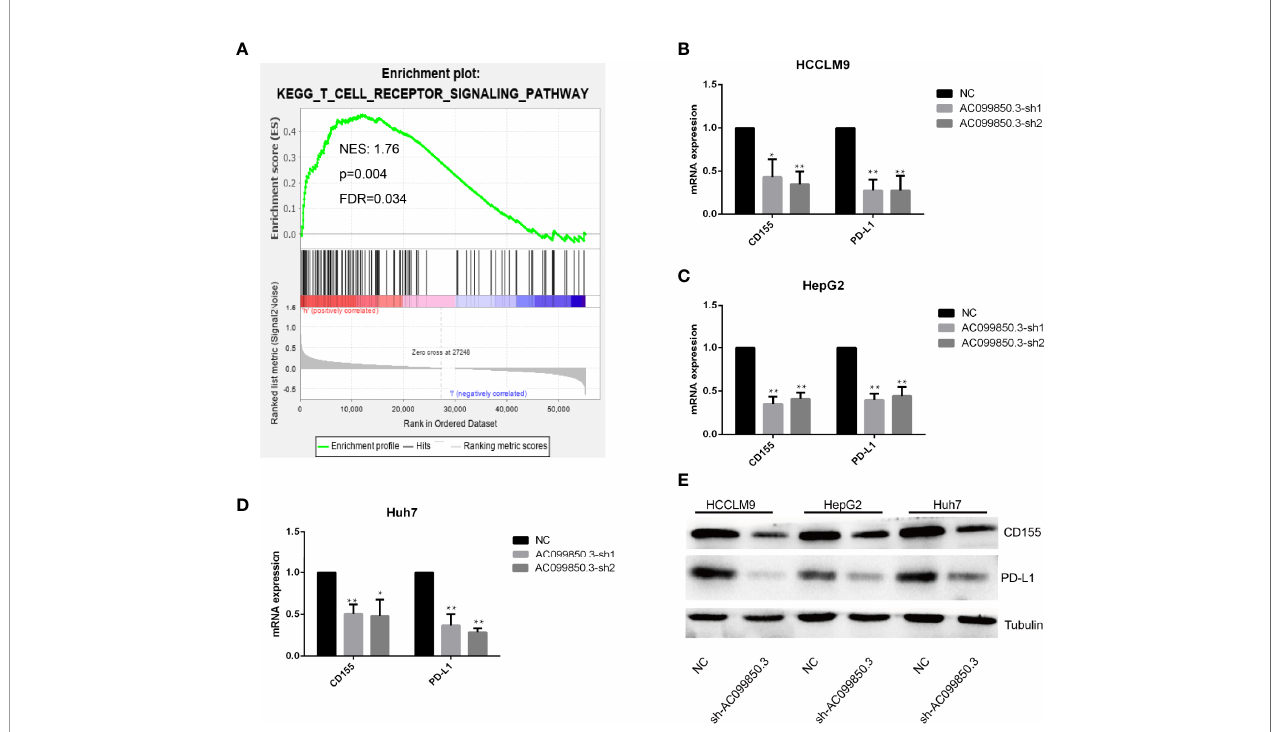
FIGURE 11 | The relevant immune mechanism of AC099850.3. (A) GSEA showed that AC099850.3 was related to the T cell receptor signalling pathway. About the legend as described in the above Figure 10A. (B – D) The results of the PCR assay showed that the interference groups had inhibited expression of the molecules CD155 and PD-L1. (E) The results of the western blotting assay showed that the interference groups had inhibited expression of the molecules CD155 and PD-L1 in the HCC cell lines. (*P < 0.05, **P <